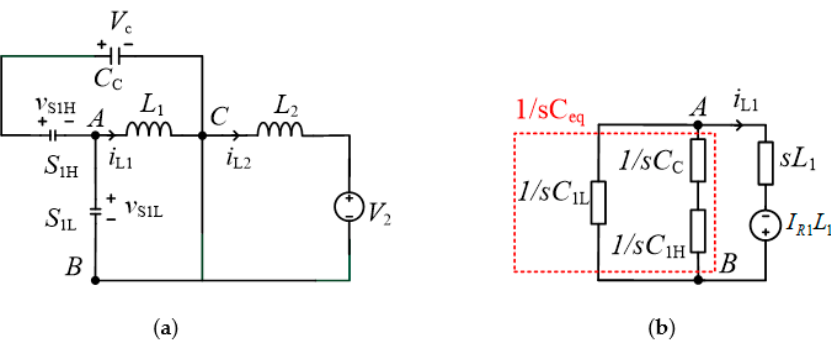
Figure 5. Equivalent circuit in the resonant period [t 2 ,t (cid:48) 2 ] : ( a ) initial circuit; ( b ) equivalent circuit with Laplace transforms.